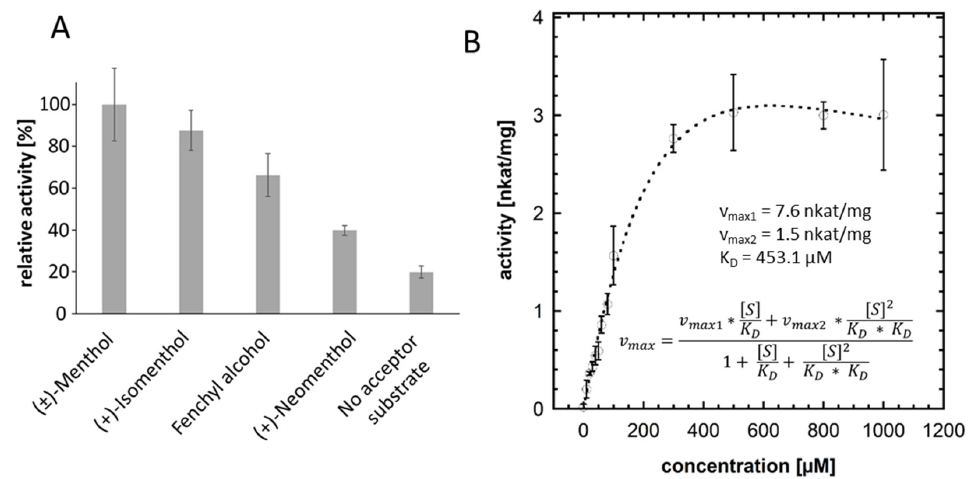
Figure 3. Determination of the relative enzymatic activities with UDP Glo™ Glycosyltransferase assay ( A ) and UGT93Y1 enzyme kinetics for (±) ‐ menthol ( B ). The relative enzyme activity was calculated after measuring the release of UDP during the glucosylation reaction. The highest enzymatic activity was set at 100%, and the relative enzyme activities calculated ( A ). The enzyme activity versus substrate concentration graph for UGT93Y1 from C. sinensis var. sinensis was determined using the UDP Glo™ Glycosyltransferase assay. The calculation was performed with KaleidaGraph (https://www.synergy.com/; v4.5.4; accessed on 9 September 2021).